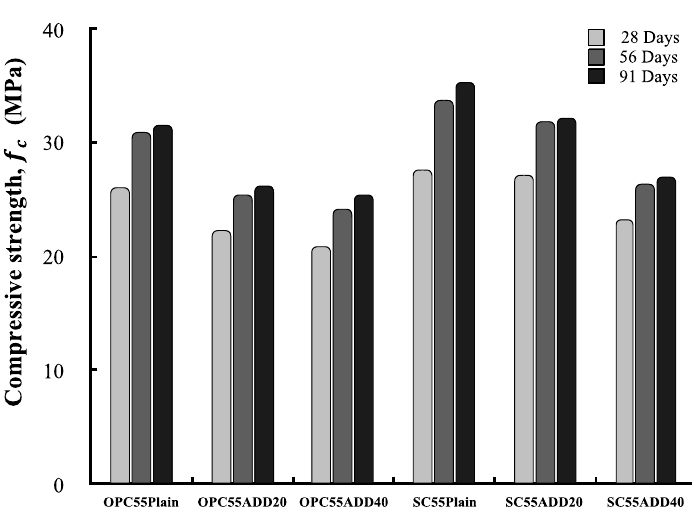
Figure 14. Compressive strength of LRM concrete as a function of cement type.